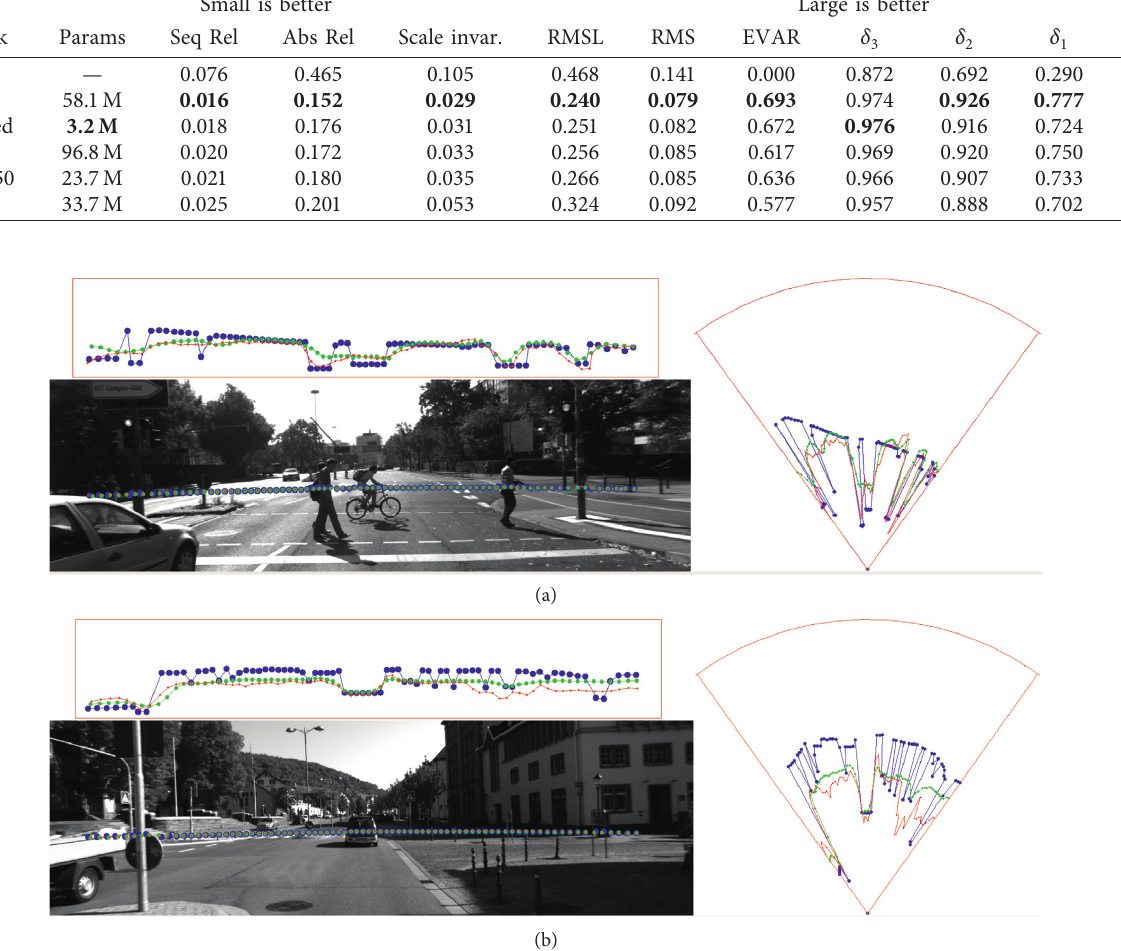
Figure 4: Comparison between VGG19 (green) and the proposed model (red) on the KITTI testing dataset. Ground truth is in